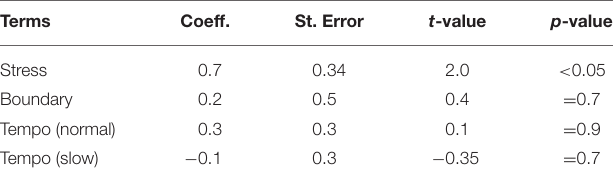
TABLE 9 | Additive model of vocalic spectral emphasis: prosodic effects.